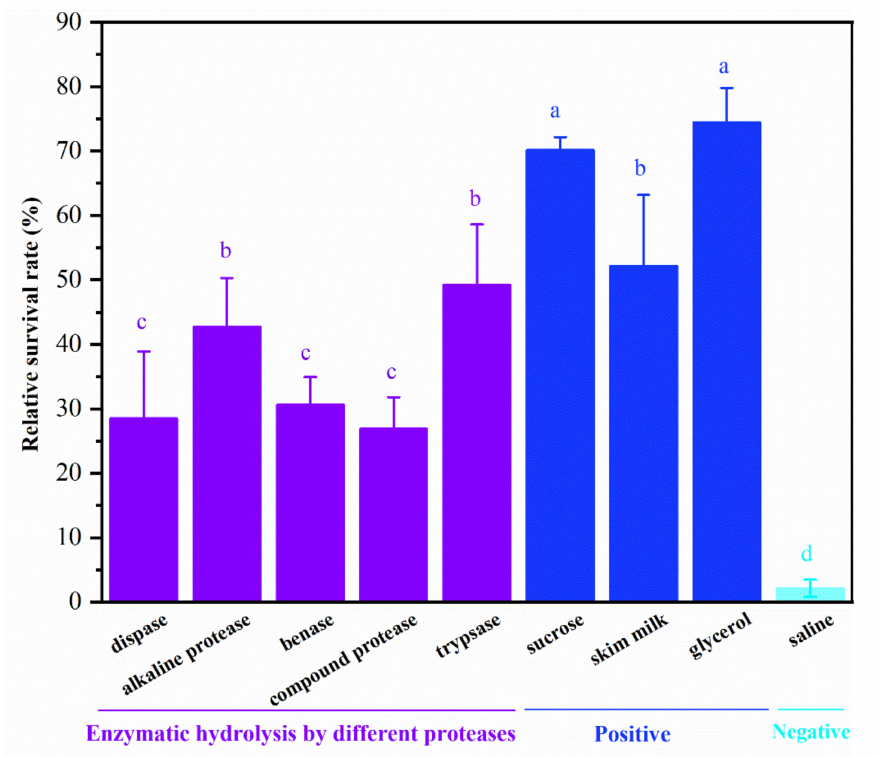
Figure 1. The antifreeze activities of different enzymatic hydrolysis samples (1 mg/mL), positive controls (1 mg/mL sucrose, 1 mg/mL skim milk, and 20% ( v / v ) glycerol), and negative control (sterilized saline) on L. rhamnosus frozen at − 20 ◦ C for 24 h. The bars with different letters indicate significant differences ( p <